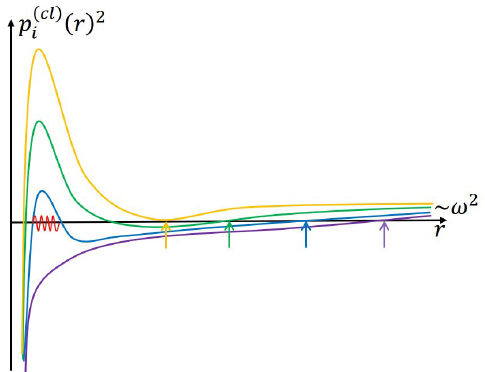
( cl ) ( r ) 2 for a given ( ω , l ) as a increases. Each arrow indicates the i